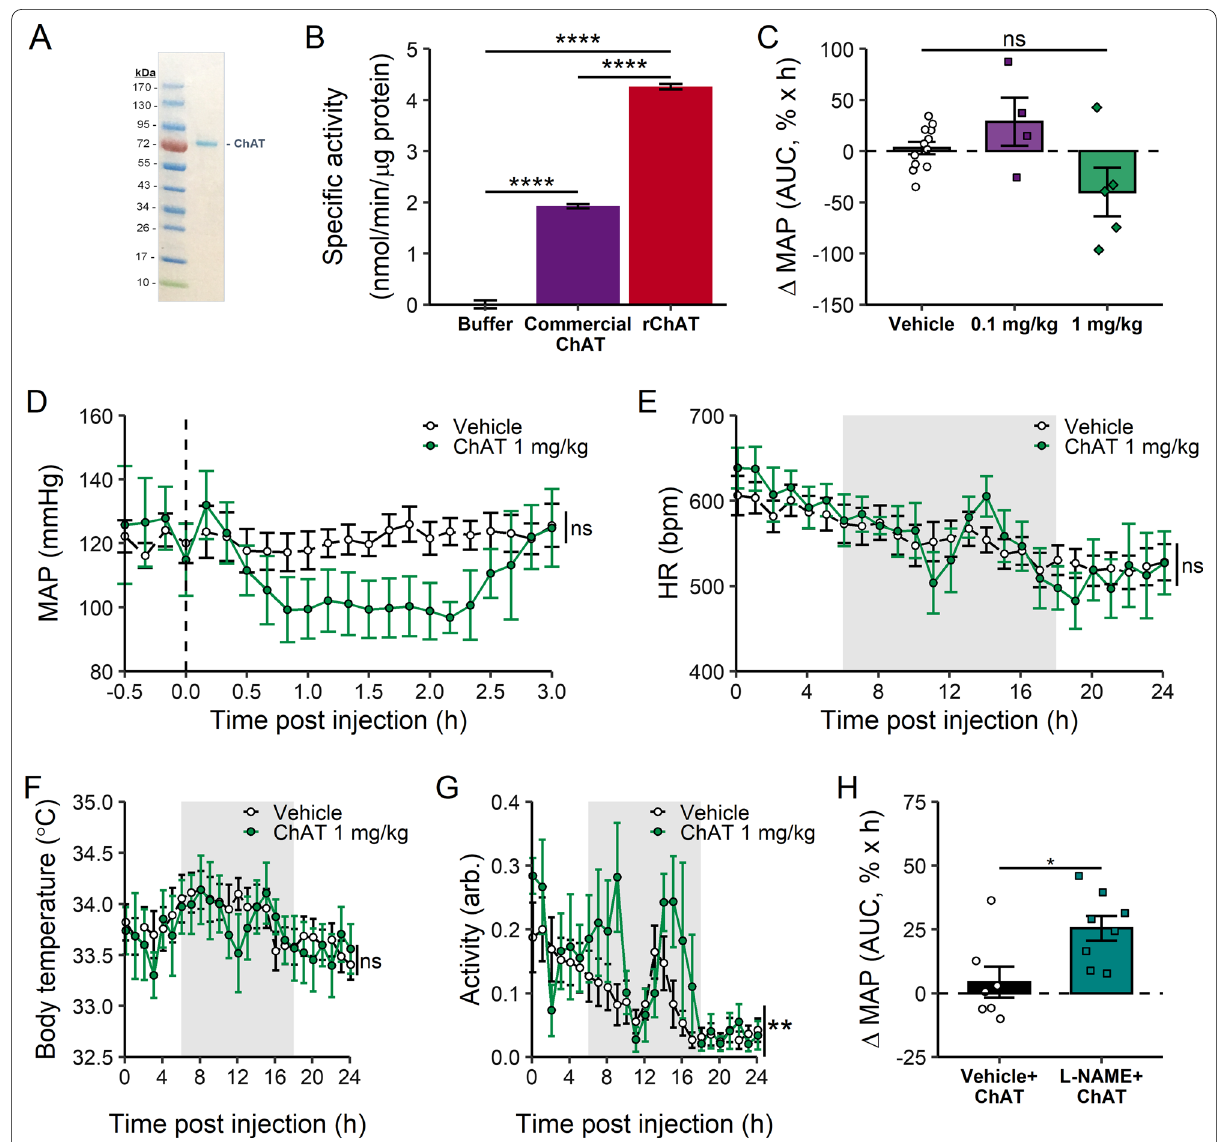
Fig. 3 ChAT administration decreases blood pressure. A SDS‑PAGE of purified recombinant human ChAT. As predicted from sequence, ChAT has a molecular weight of ~ 72 kD. B specific activity of recombinant ChAT (rChAT) and commercially available ChAT. Data represented as one assay performed in triplicate. ****p < 0.0001, one‑way ANOVA with Dunnett’s correction, C normalized MAP in the 3 h period after ChAT administration. MAP is normalized to the 30‑min period before ChAT or vehicle administration, and area under the curve is calculated from a baseline of 100%. n 5–11. ns, not significant, one‑way ANOVA with Dunnett’s multiple comparison test. D MAP after ChAT administration at time = 0. Data are averaged every 20 min and represented as group mean SEM, n 5–11. ns: not significant, two‑way ANOVA with Sidak’s multiple ± = comparisons test. E HR, F body temperature and G activity scores in the 24 h period post‑ChAT administration. Gray background indicates dark cycle. Data are averaged every hour and represented with lines as group mean SEM. ns not significant, **p < 0.01, two‑way ANOVA with Sidak’s ± multiple comparison test. H change in normalized MAP. MAP is normalized to the 30‑min period before L‑NAME or vehicle pre‑treatment. After normalization, area under the curve for 1 h post‑ChAT administration is calculated from a baseline of 100%. Negative values correspond to decrease in MAP. n 7–8. *p < 0.05, =